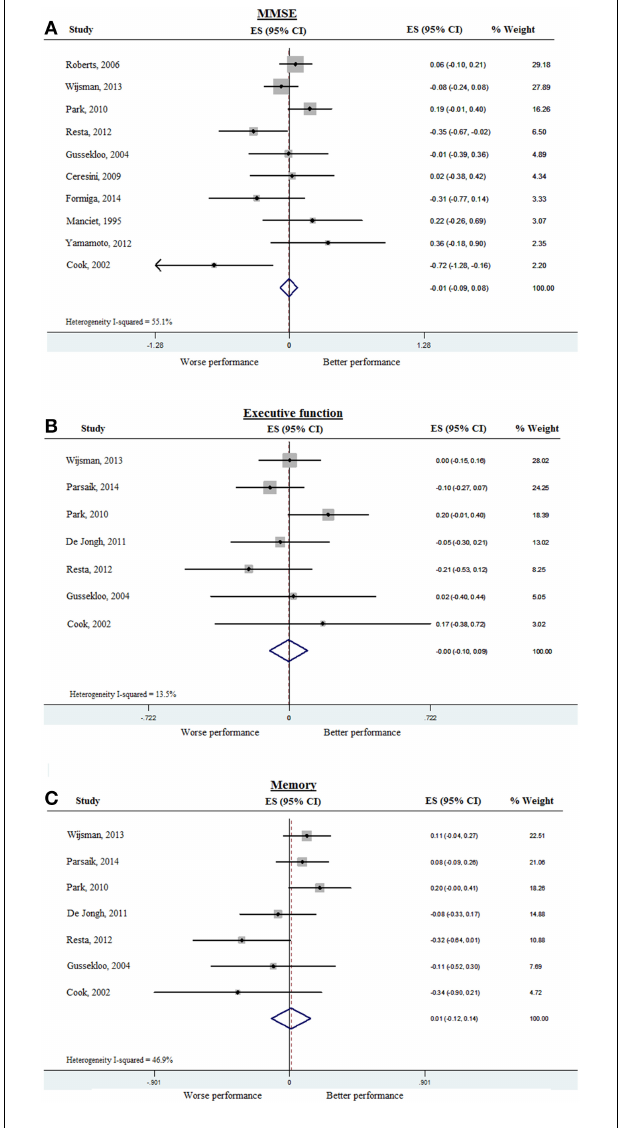
FIGURE 2 | Forest plots depicting the cross-sectional associations observed between subclinical hypothyroidism (compared to controls) and cognitive performance in 10 studies, arranged according to the weight of the studies. Data was pooled from cross-sectional studies and baseline data of prospective studies. (A) Association between subclinical hypothyroidism and global cognition as measured by MMSE, (B) Association between subclinical hypothyroidism and executive function, and (C) Association between subclinical hypothyroidism and memory. The pooled effect sizes are displayed as diamonds. MMSE, Mini-mental state